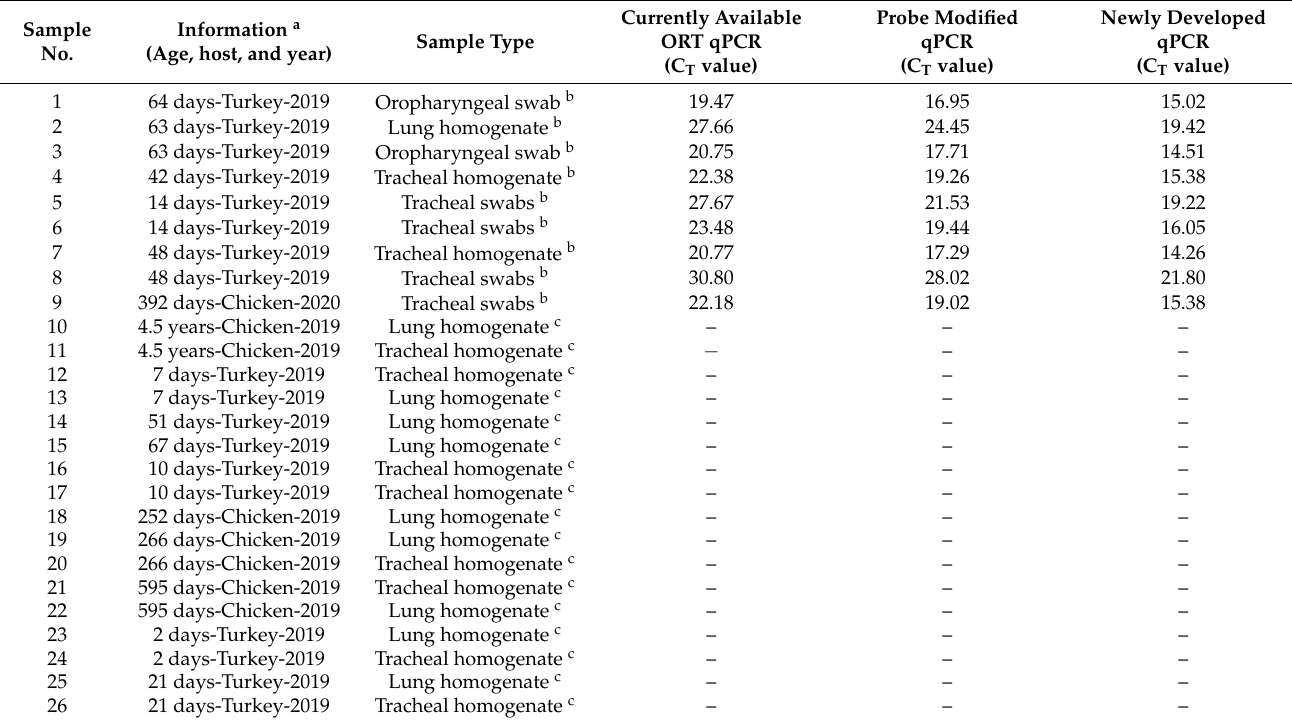
Table 3. Known positive and negative ORT clinical samples included in this study and comparison among C T values obtained from testing positive clinical samples using the three qPCR